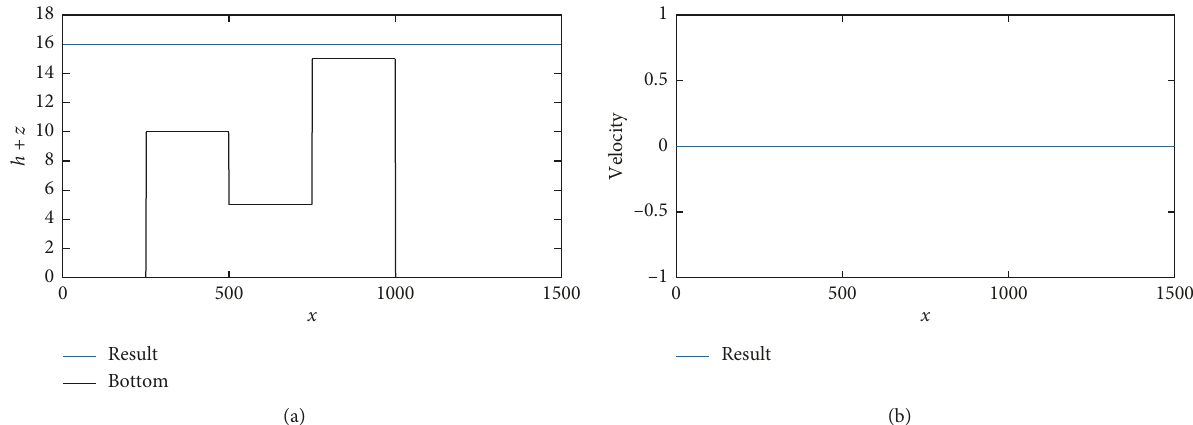
Figure 1: Water depth (a) and velocity (b) of still water stationary state at final time 100s.